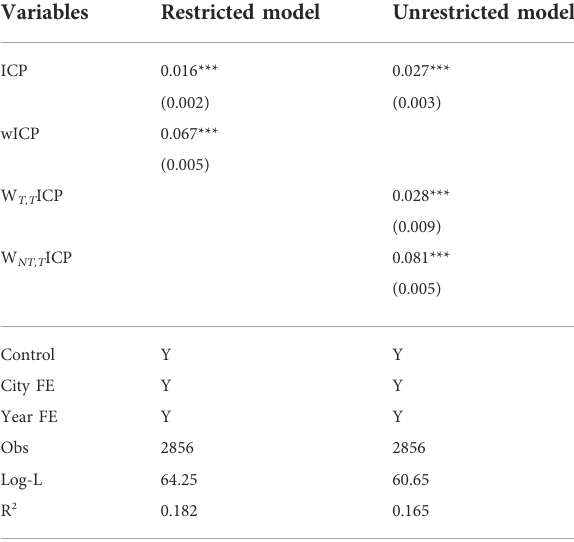
TABLE 11 Re-estimation based on an expanded SDID